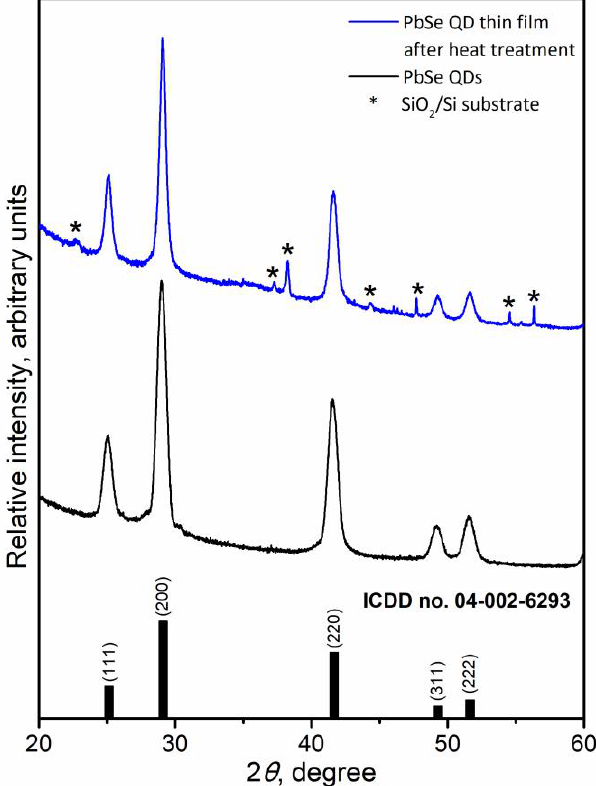
Figure 2. XRD patterns of the as-synthesized PbSe QDs (bottom) and the resultant PbSe QD thin film (top).